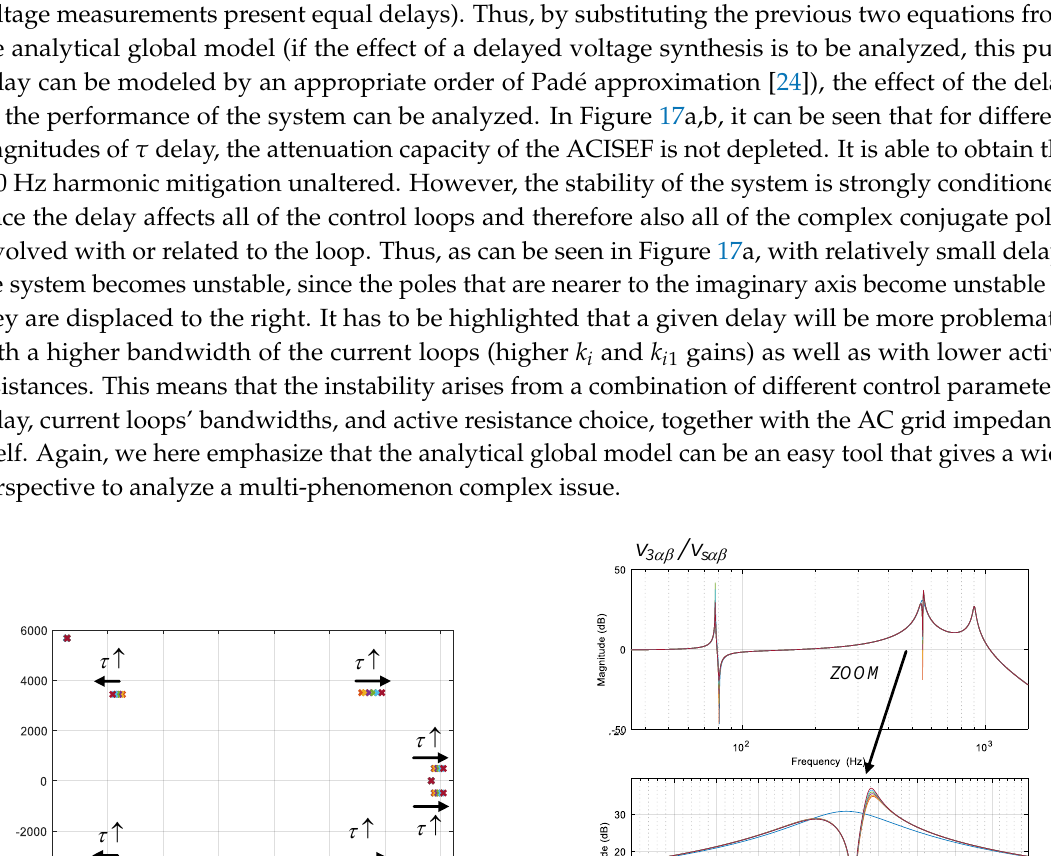
Bode plot of v 3  (s)/ v s  (s) . 626